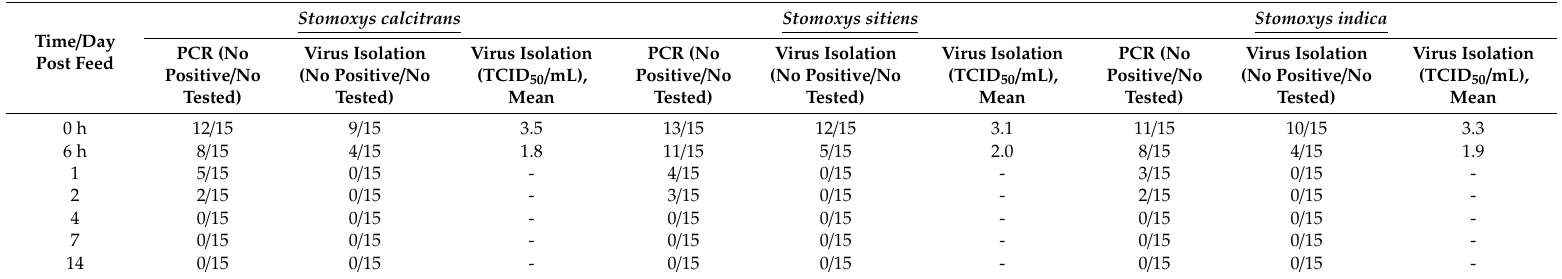
Table 1. PCR and virus isolation results of Stomoxys spp. at di ff erent time intervals following feeding on lumpy skin disease virus LSDV infected donor animals.